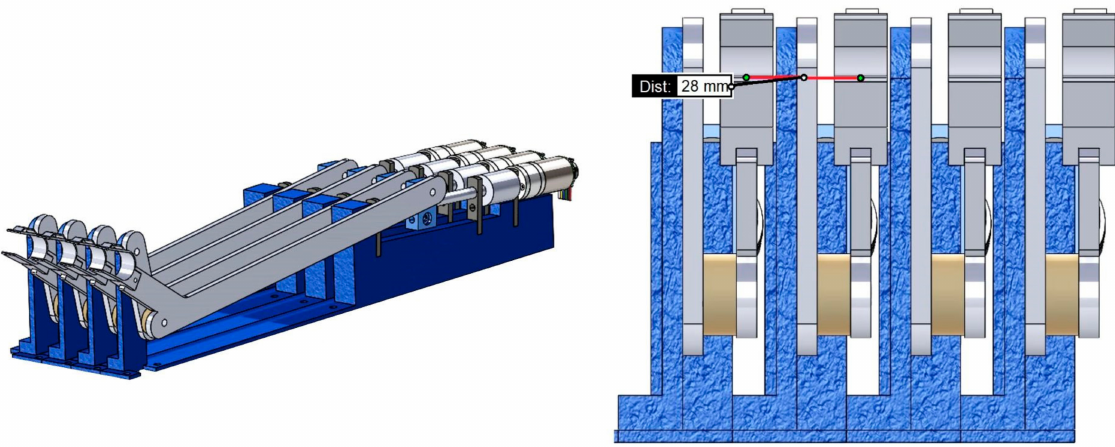
Figure 25. Four mechanisms from the index to small